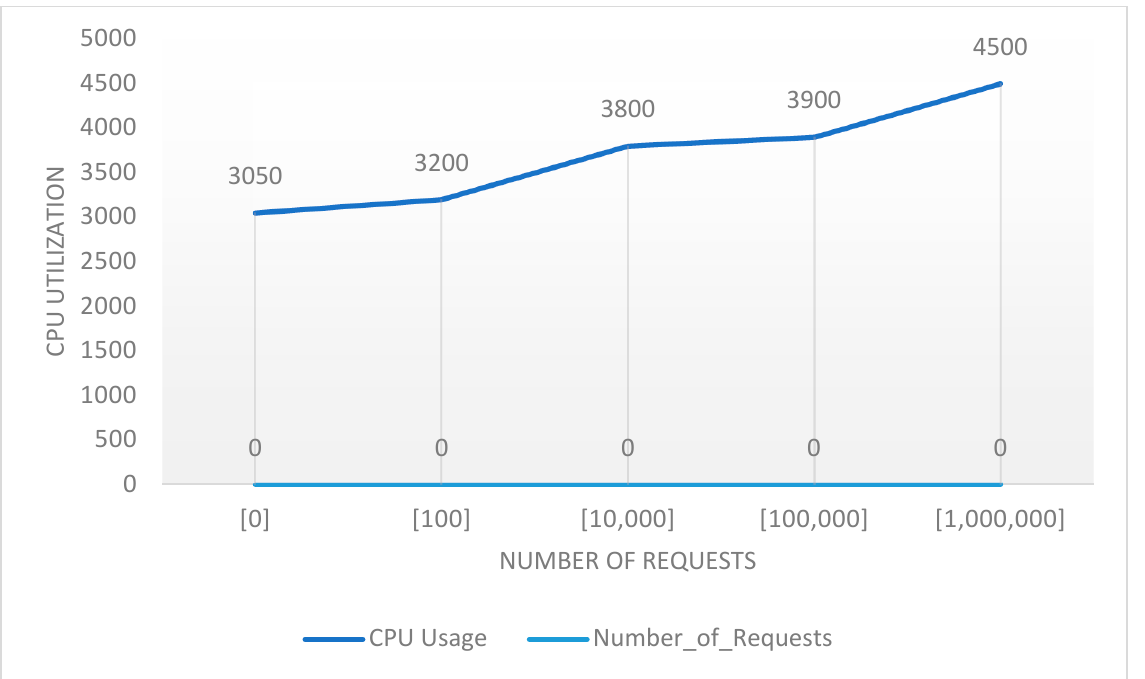
Figure 23. Performance of the scaled system by 3 nodes: CPU usage.